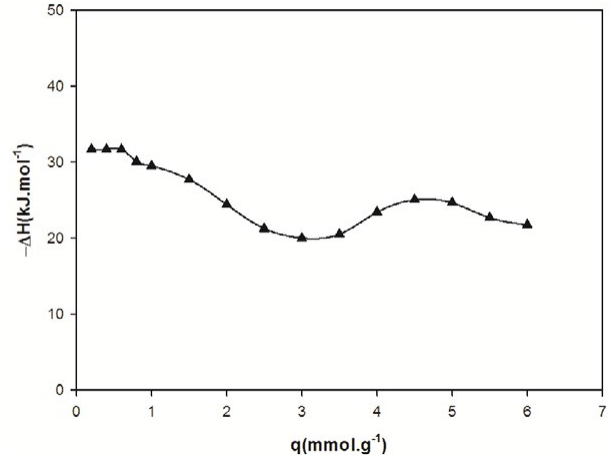
Fig. 7. Isosteric heat of adsorption against surface loading for adsorption of CO 2 onto NDC.